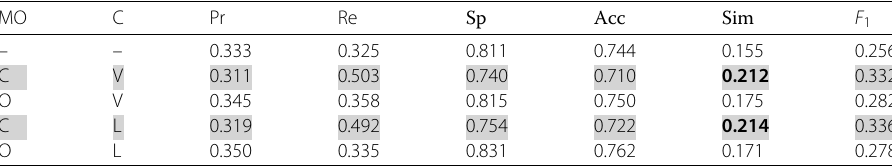
Table 4 Evaluation results for the predicted masks of the GMM after applying post-processing methods on the masks. The input images are pre-processed by applying CLAHE on the respective color channel